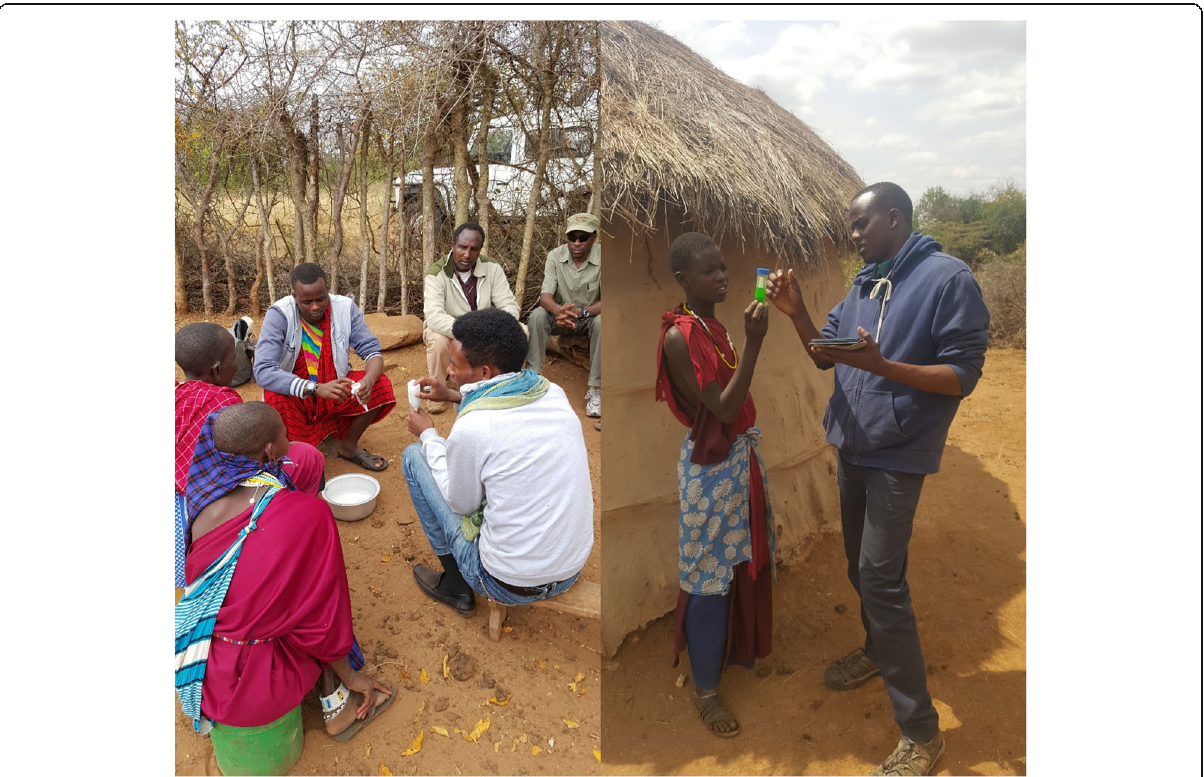
Fig. 3 Teaching Maasai women how to use the thermometers and measuring soap